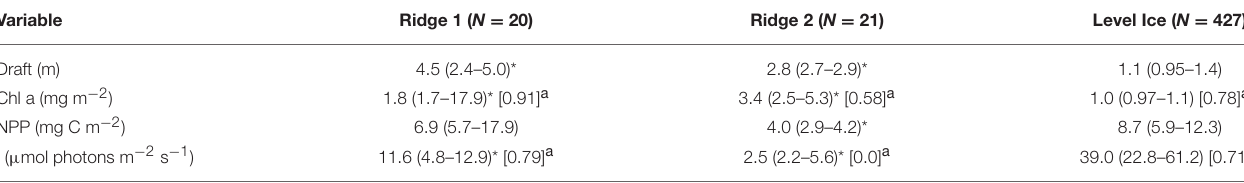
TABLE 4 | Comparison of chlorophyll a biomass and net primary production between sea ice ridges and level ice at station 224. Variable